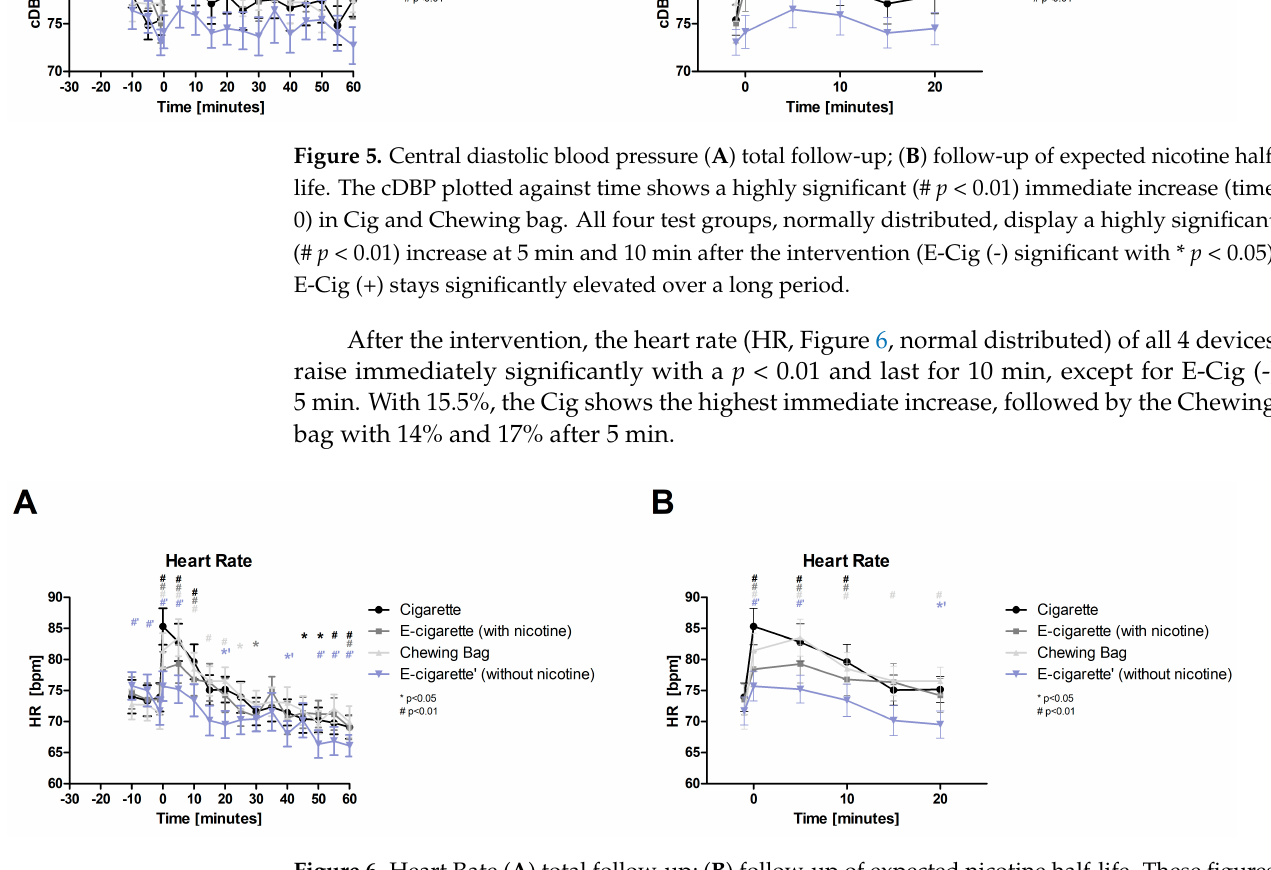
Figure 6. Heart Rate ( A ) total follow-up; ( B ) follow-up of expected nicotine half-life. These figures show the HR over the time of the test day. At the intervention (time 0) and 5 min after, all four groups, normally distributed, show a highly significant (# p < 0.01) raise; at 10 min the increase persists in all groups except for E-Cig (-).